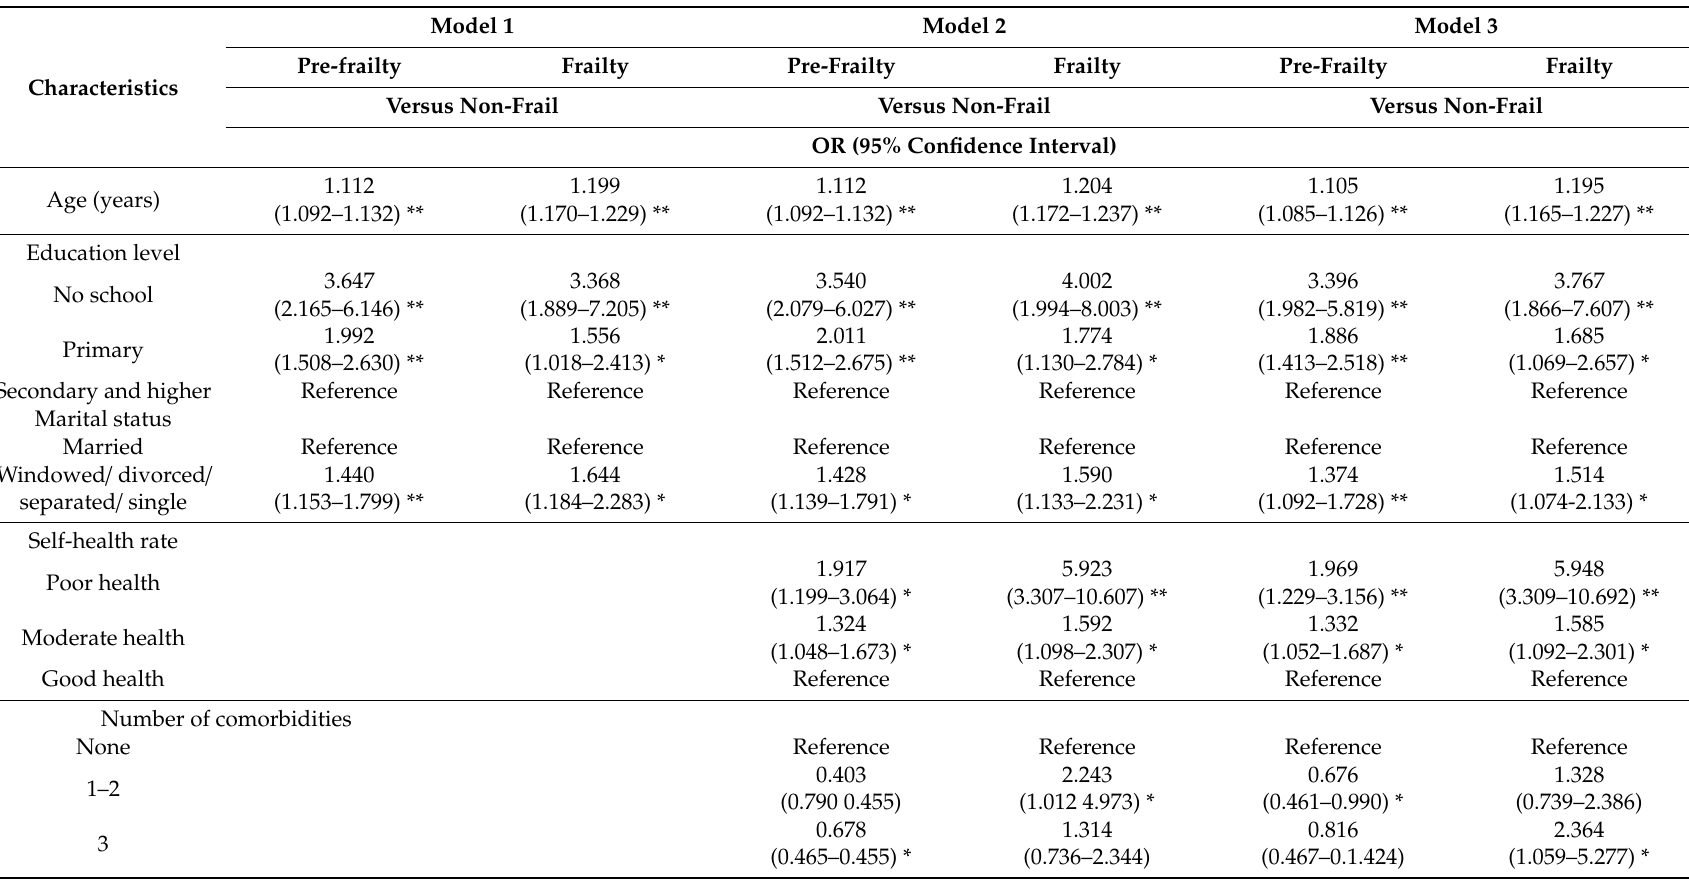
Table 3. Multinomial regression analysis assessing the association between socio-demographic, health and anthropometric characteristics and